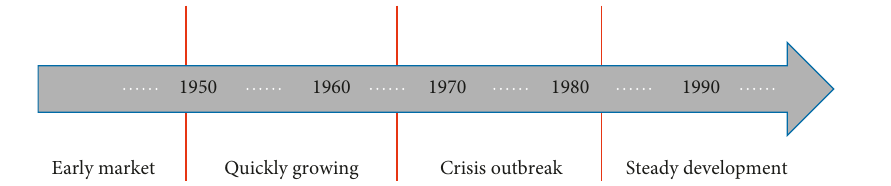
Figure 1: Market development